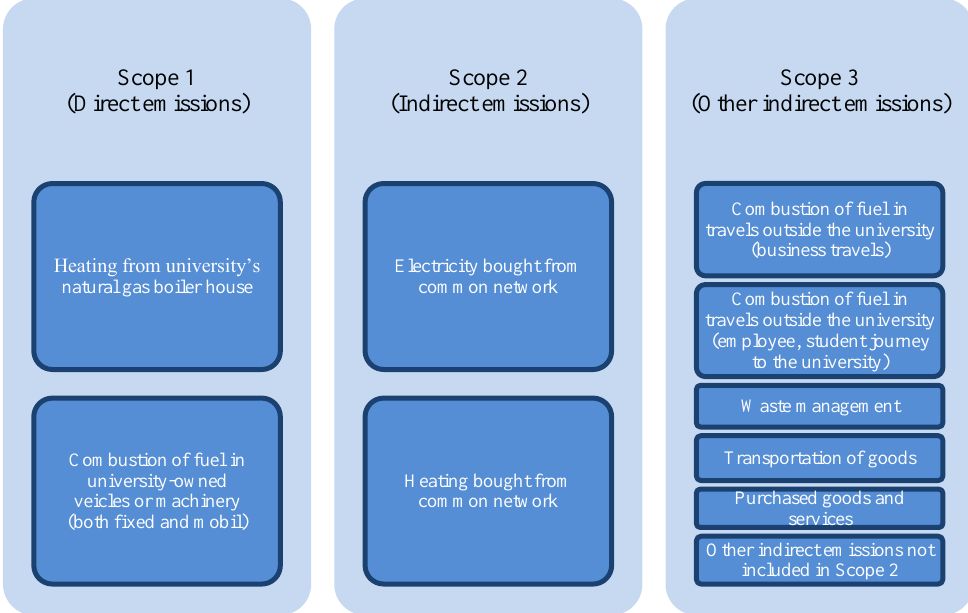
Fig. 1. Case study emission break-down according to the EPA GHG protocol